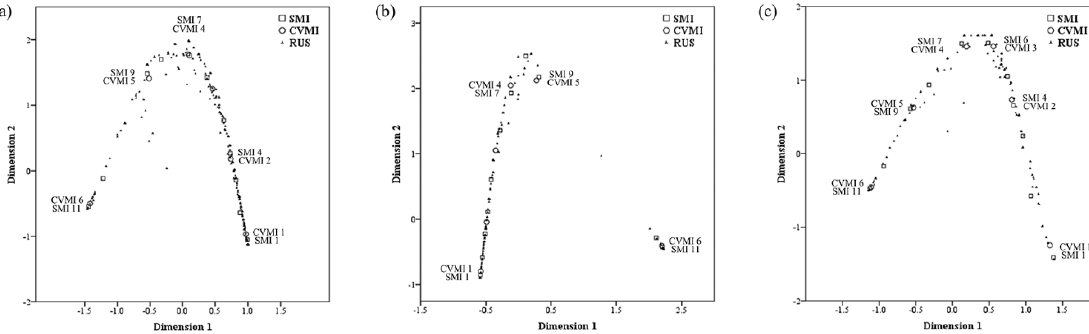
Figure 3. Multiple correspondence analysis joint plots of the SMI, CVMI, and RUS skeletal maturity scores: ( a ) All subjects; ( b ) Males; ( c ) Females.